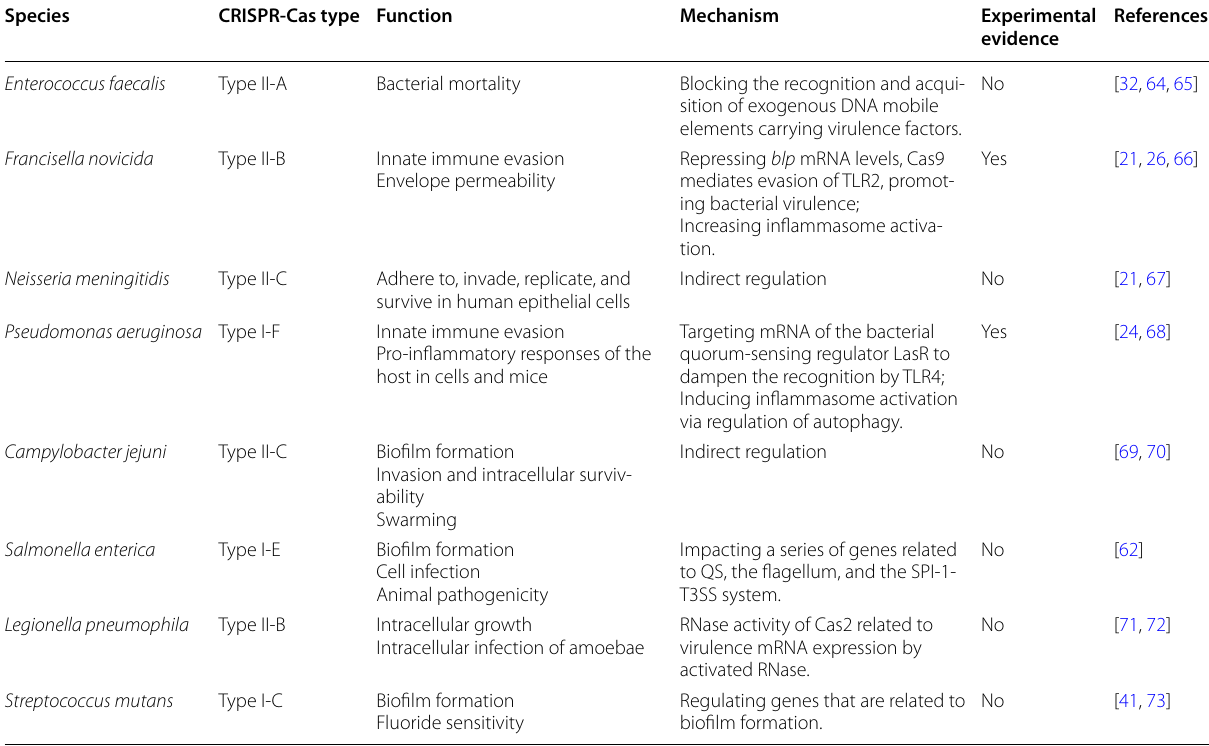
Table 1 Some examples of endogenous targeting by CRISPR-Cas system